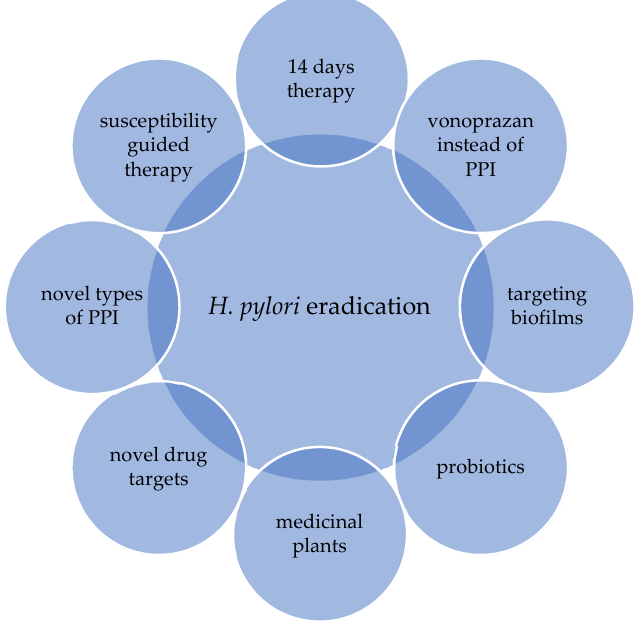
Figure 2. Current strategies for improving the effectiveness of eradication therapy. Data from a multicenter prospective non-interventional study that included 21,533 patients from 27 European countries showed that a longer treatment duration, higher acid inhibition and compliance were associated with higher eradication rates [18]. The study revealed that European recommendations are being slowly and heterogeneously incorpo- rated into routine clinical practice. Namely, the results of the same study indicate a reduc- tion in the prescription of triple therapy, a longer duration of treatment and the use of a higher dose of PPI. According to the study, the above resulted in an increase in overall effectiveness (84–90%) [18].